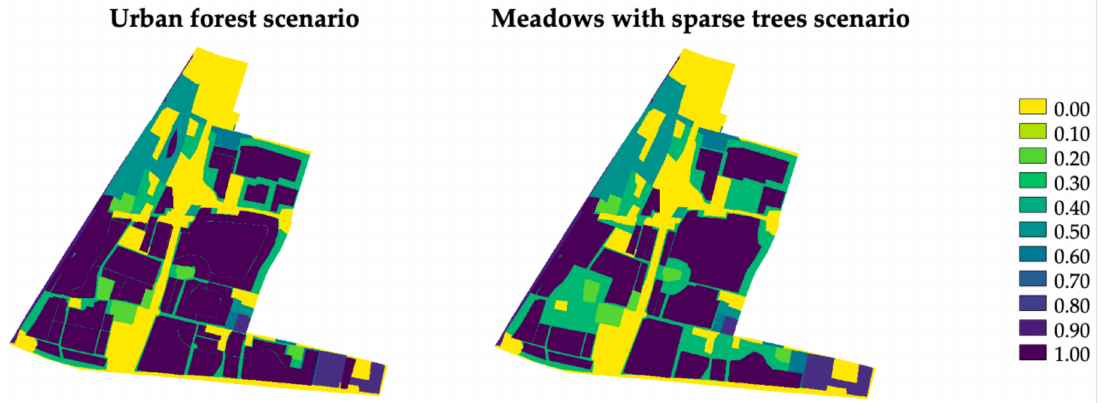
Figure 6. Habitat quality index for the two intervention scenarios.